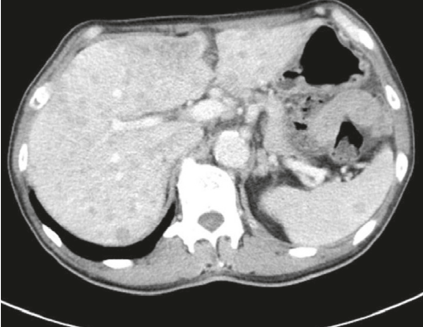
Figure 3: Abdominal contrast-enhanced CT shows multiple low- density areas, hepatomegaly, and metastasis to the